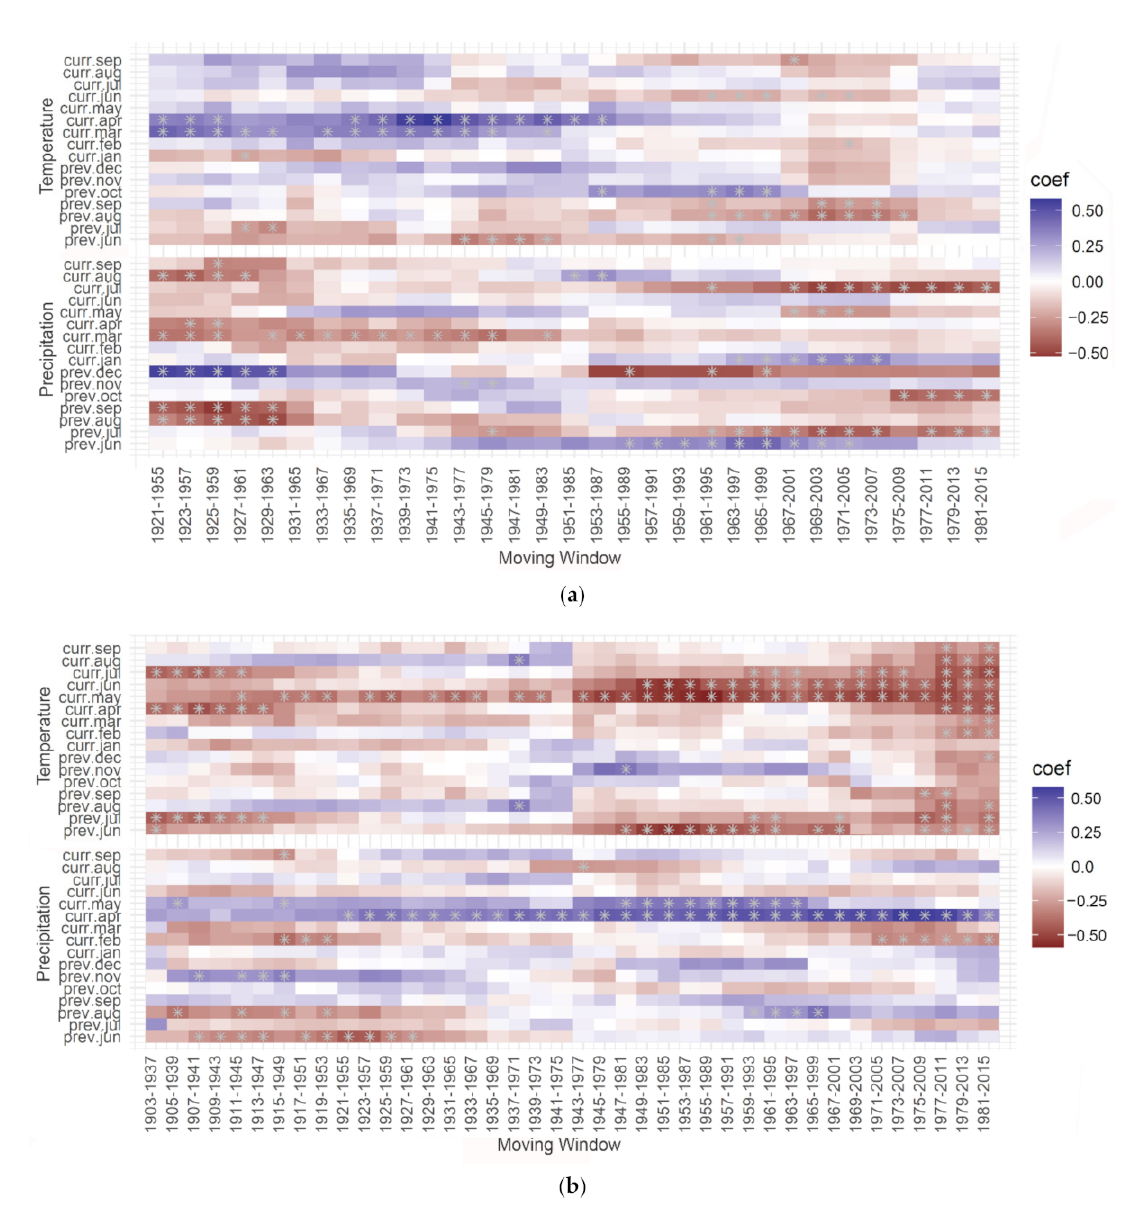
Figure A4. Moving windows correlation analysis between climate and radial growth of ( a ) Abies spectabilis and ( b ) Betula utilis. The correlation windows were of 35 years with two years’ offset. Asterisks (*) denote the significance of correlation (at 0.05) in either